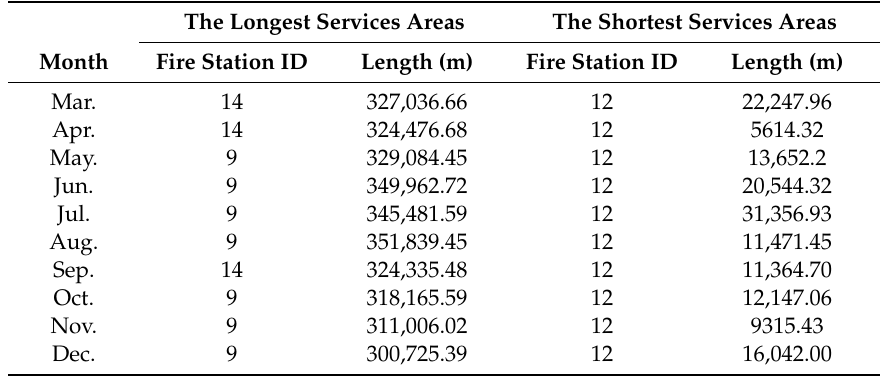
Table 1. The fire stations that have the longest and shortest service lengths in di ff erent time slices. The Longest Services Areas The Shortest Services